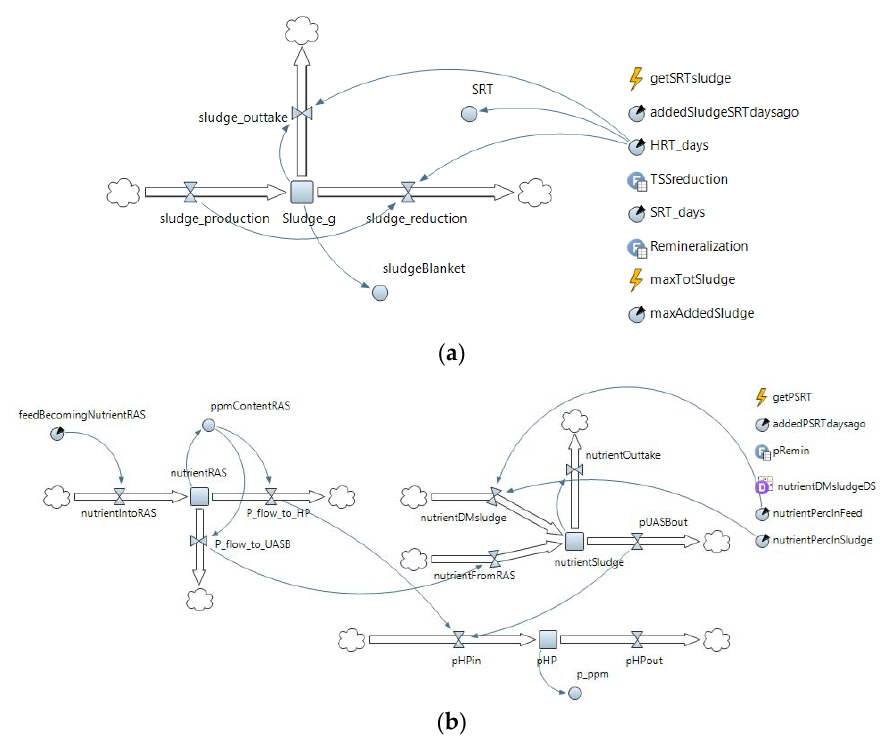
Figure A3. Software diagram covering sludge balance as well as the remineralization rate of P in the ANRC. ( a ) Anaerobic remineralization performance; ( b ) P flow of the ANRC. Water 2016 , 8 , 303